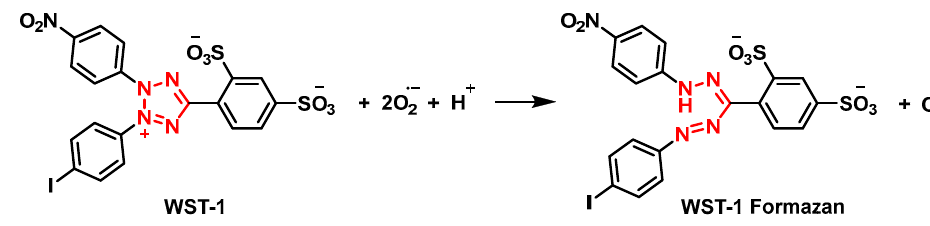
Figure 42. Structure of WST-1 (4-(3-(4-iodophenyl)-2-(4-nitrophenyl)-2H-tetrazol-3-ium-5-yl) benzene-1,3-disulfonate).